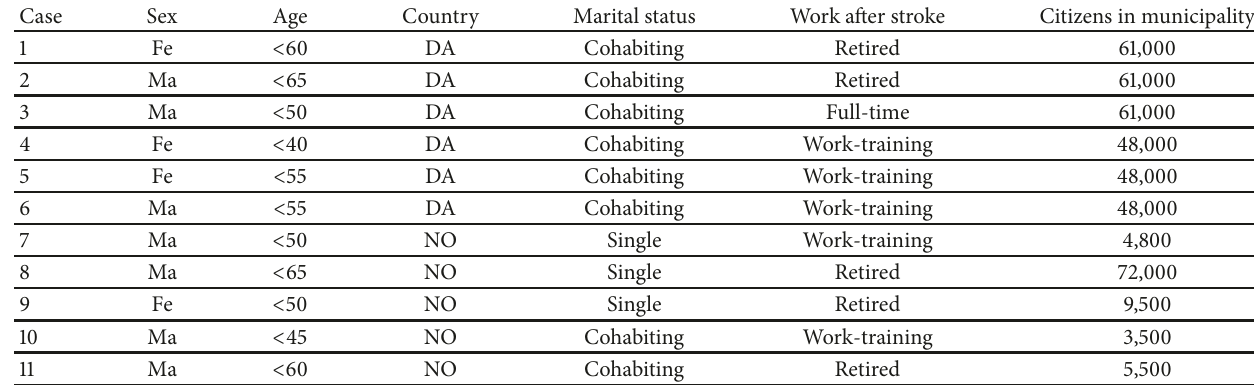
Table 1: Participants’